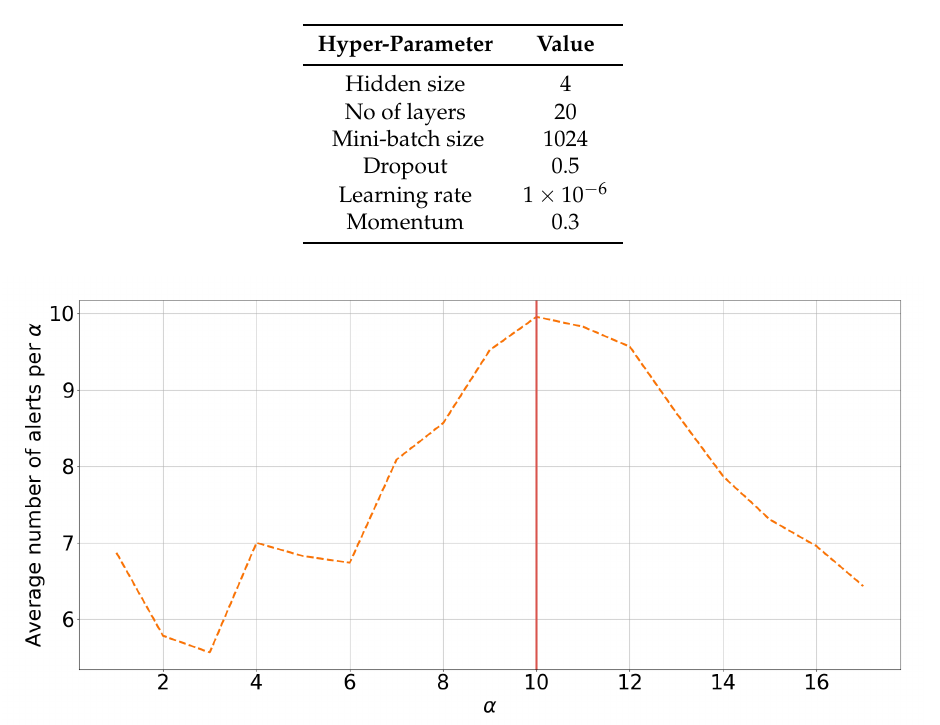
The grid search-optimised hyper-parameters used to train a GRU-AE used on multidimensional time-series data.